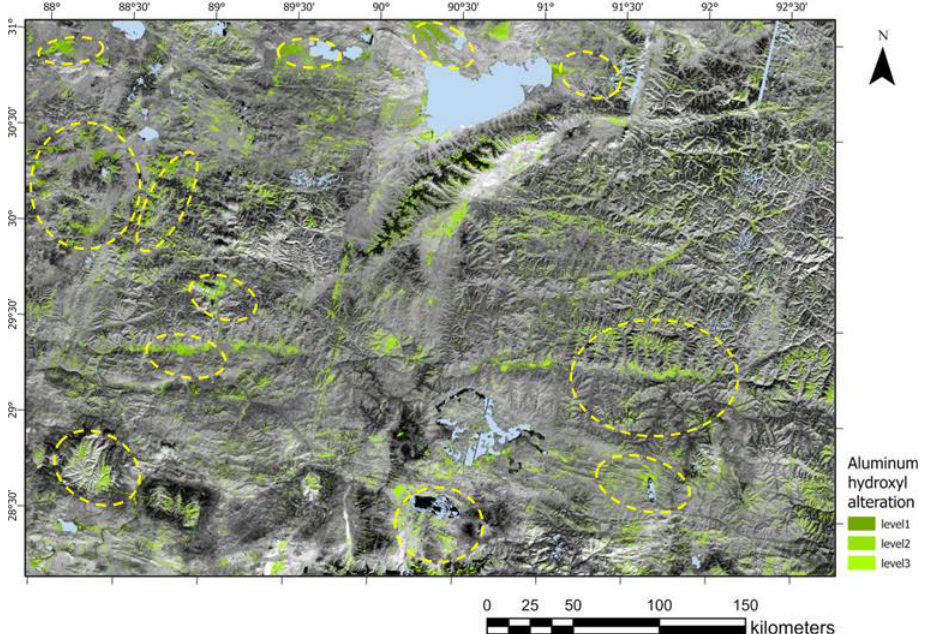
Figure 12. Al hydroxyl alteration map of the Gondwana region obtained by the EPCA method. (The yellow dashed boxes in the figure indicate the more pronounced spatial aggregation of alteration information.)